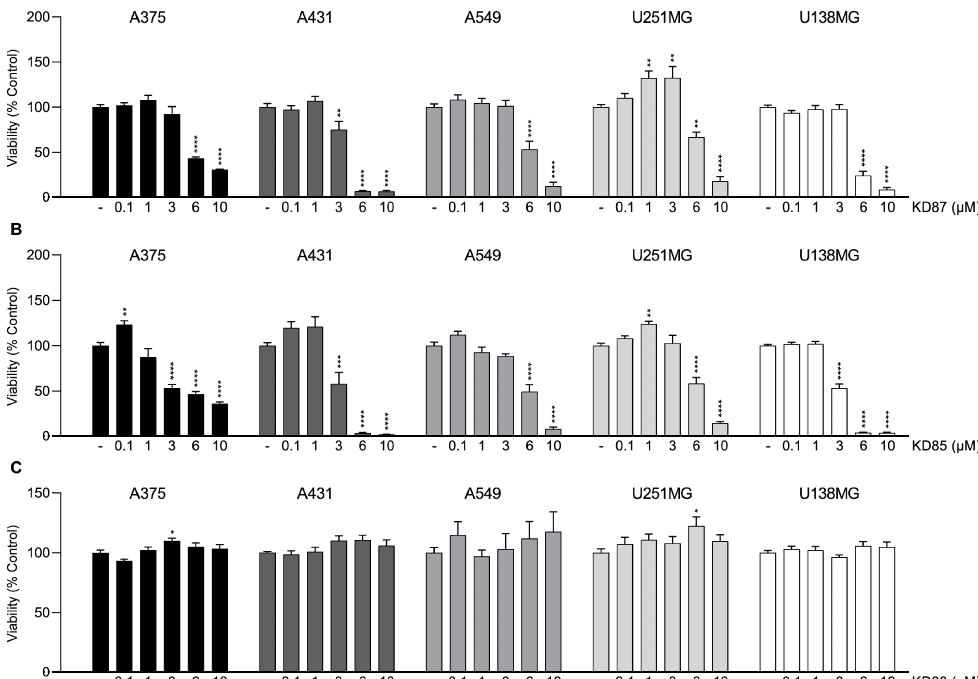
Figure 2. Effect of increasing concentrations of KD87 ( A ), KD85 ( B ), and KD88 ( C ) on viability of various cancer cells. A375 (melanoma; black columns), A431 (skin squamous cell carcinoma; dark grey columns), A549 (non-small cell lung carcinoma; grey columns), U251MG (glioblastoma; light grey columns), or U138MG (glioblastoma; white columns) were incubated for 48 h with the appropriate compounds or vehicle followed by determination of cell viability by WST-1 assay. Percent control represents comparison with vehicle-treated cells (100%) in the absence of test substance. Values are mean ± standard error of the mean (SEM) of n = 15 in all panels, except n = 14 for A375 and A431 cells in panel B and n = 14–15 for A375 cells in panel C, from four (A375, A431) or five (A549, U251MG, U138MG) independent experiments. * p ≤ 0.05, ** p ≤ 0.01, *** p ≤ 0.001, **** p ≤ 0.0001 vs. vehicle control; one-way ANOVA with Dunnett’s post hoc test.